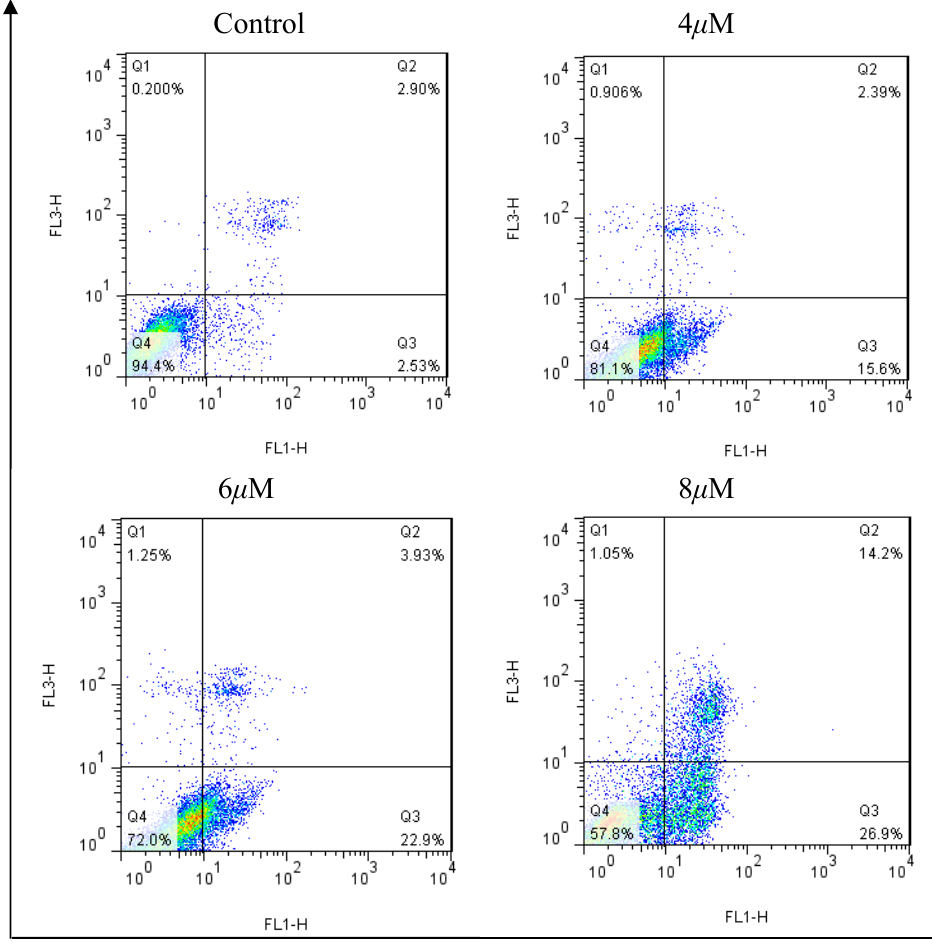
induced apoptosis in HepG2 cell with the density of 4, 6, 8 μ M. Figure 3. Compound D 9 Data are plotted as the mean ± SD (* P < 0.0005 vs.